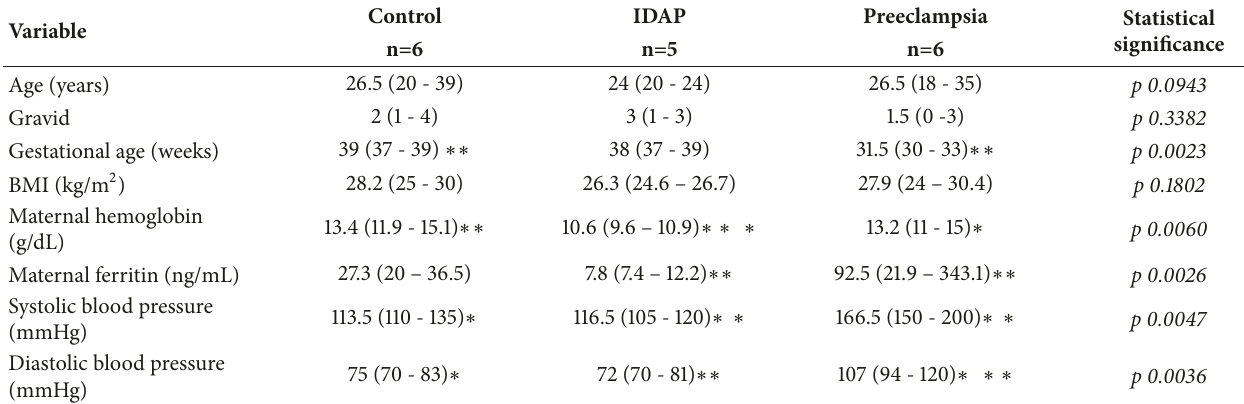
Table 1: Demographic and clinical characteristics of